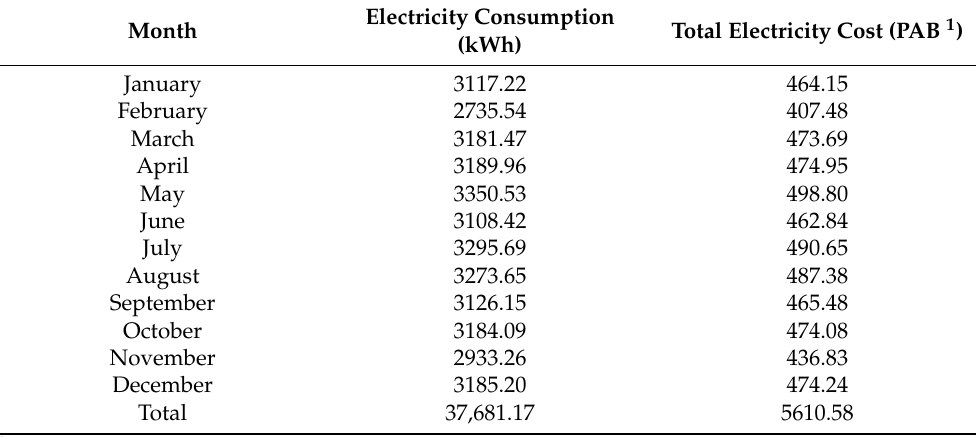
Table 7. Electricity consumption and cost of electricity consumption of the optimized urbanization in a